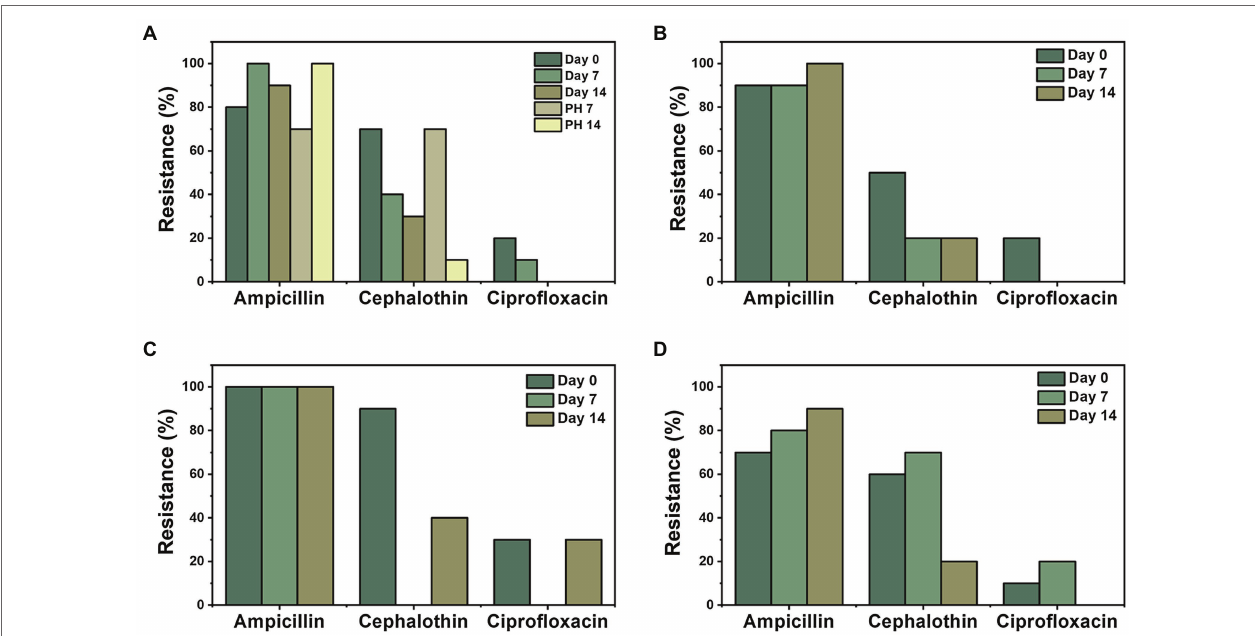
FIGURE 5 | Distribution of ARB over time (days 0, 7, and 14 and post-harvest (PH) days 7 and 14) for three antibiotics that displayed the highest prevalence of resistance (ampicillin, cephalothin, and ciprofloxacin) among response materials: (A) foliage, (B) leachate, (C) soil, and (D) wastewater source.